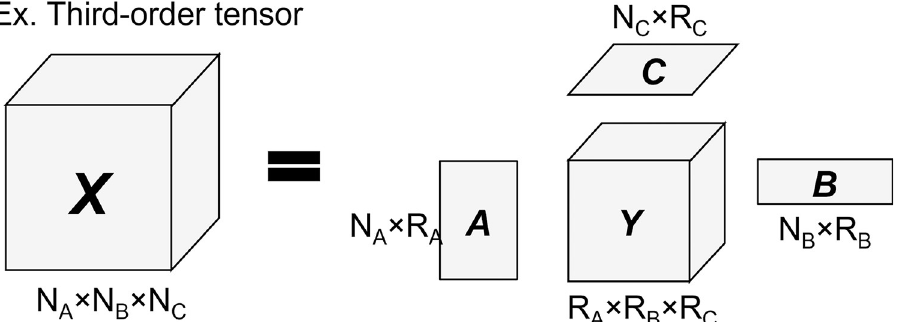
Fig 3. Example of the third-order Tucker